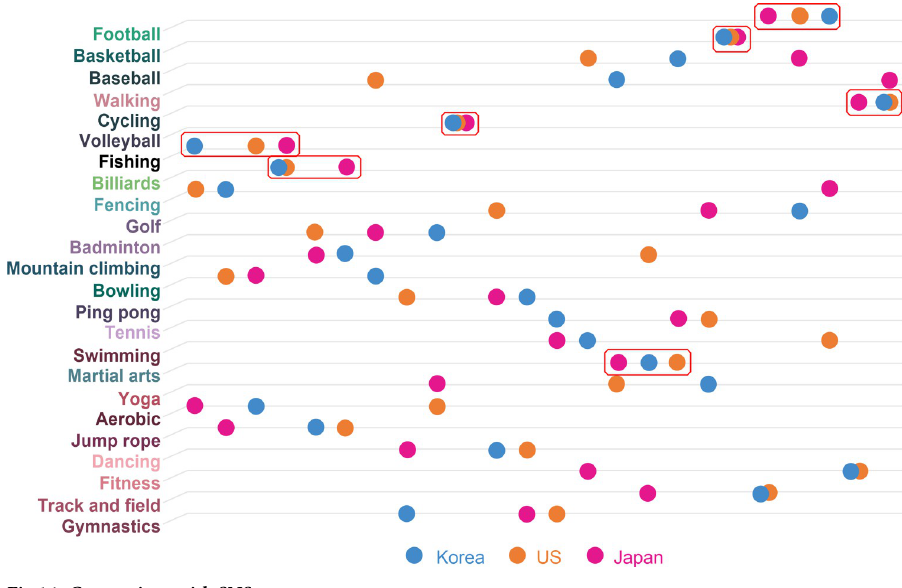
Fig 14. Comparison with